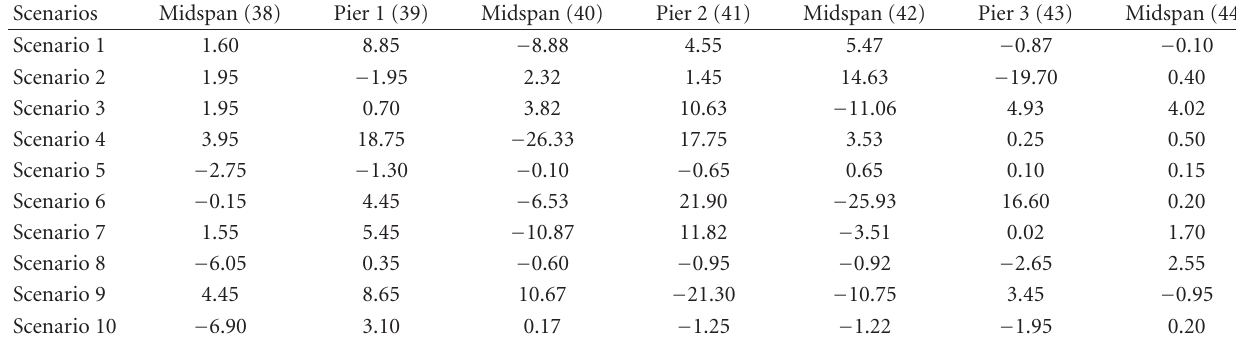
Table 7: Live load stresses from sensors—north side panels (psi ∗ ).